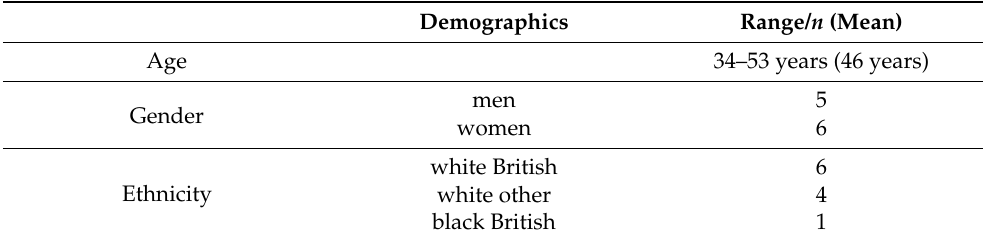
Table 2. Characteristics and demographics of service providers